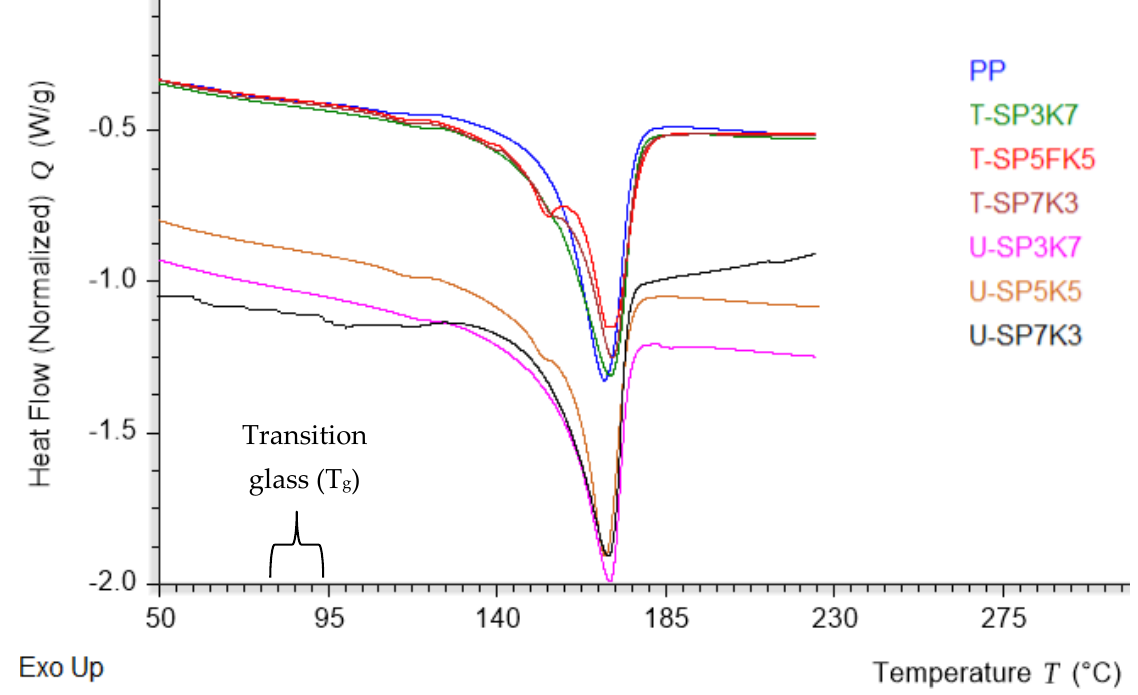
Figure 3. DSC curve of SPF/KF/PP hybrid composite with different composition ratios. Figure 4. DSC curve of SPF/KF/PP hybrid composite with different composition ratios. Table 3. Transition glass temperature, melting point temperature, enthalpy, and degree crystallinity of SPF/KF/PP hybrid composite.